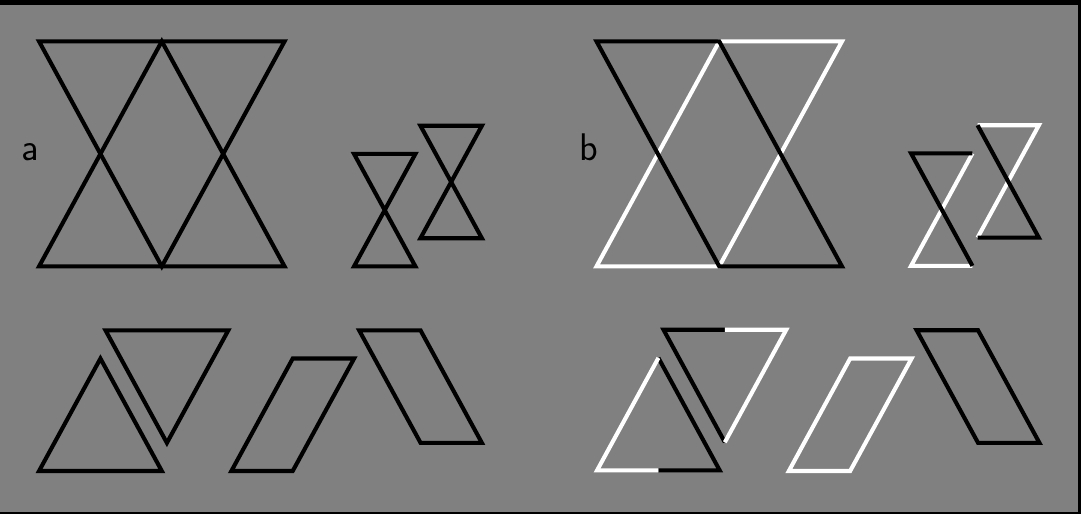
Figure 1. Contrast polarity and perceptual organization. Both compound stimuli can be described (i.e., interpreted) as consisting of, for instance, two triangles, two diabolos, or two parallelograms. The parallelogram interpretation is probably the weakest one in panel ( a ); but due to contrast polarity reversals, it is definitely the strongest one in panel ( b ) (after [8]).